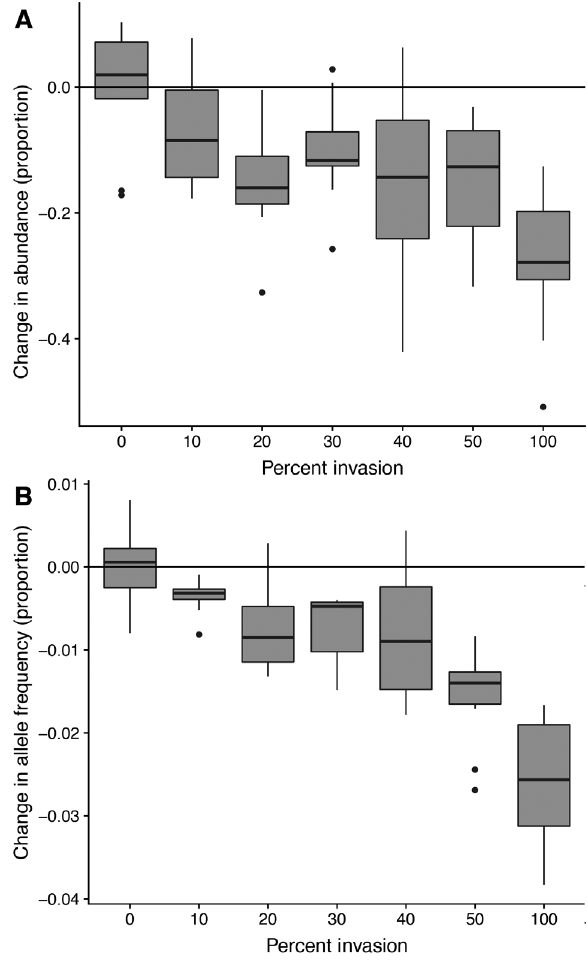
Fig. 4. (A) Magnitude of demographic decline and (B) ge- netic change observed after 50 yr of invasion by escaped farmed salmon into a wild population. Annual levels of inva- sion vary from 0 to 100% of the wild population. Changes were calculated by comparing each scenario (and iteration) against the mean of the zero-invasion scenario at the end of the invasion period. The box limits represent the third (75th percentile) and first (25th percentile) quartile, with whiskers showing the 1.5× interquartile range. The centre line within boxes represents the median and the points outside the boxes represent outliers. Each boxplot represents results based on 10 iterations for the